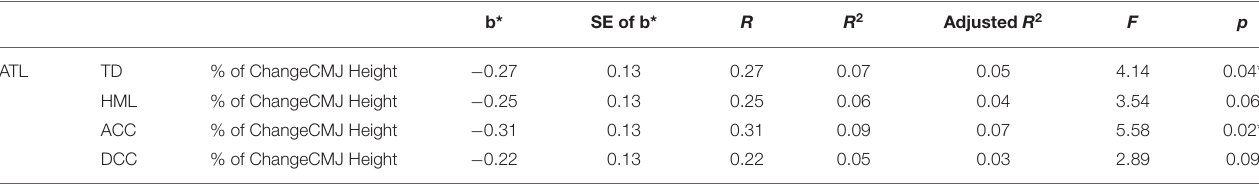
TABLE 5 | Values of regression analysis explaining the percentage of b* change of CMJ b* on the remaining R